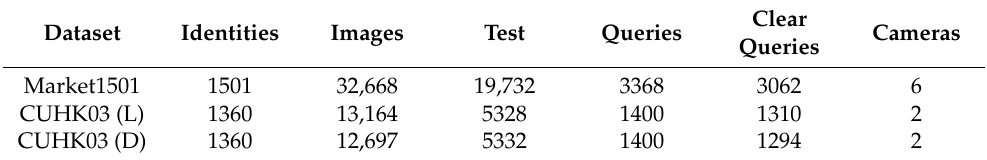
Table 3. The details of the used datasets.